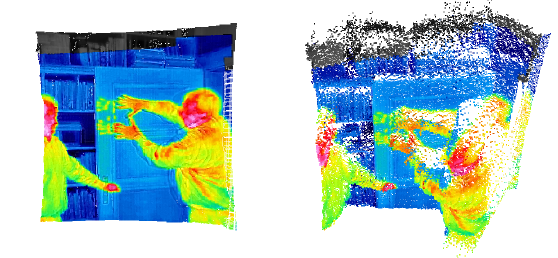
Figure 15: Frontal view onto a non-planar scene (left) and a view clearly showing the erroneous shifts of IR texture in the point cloud